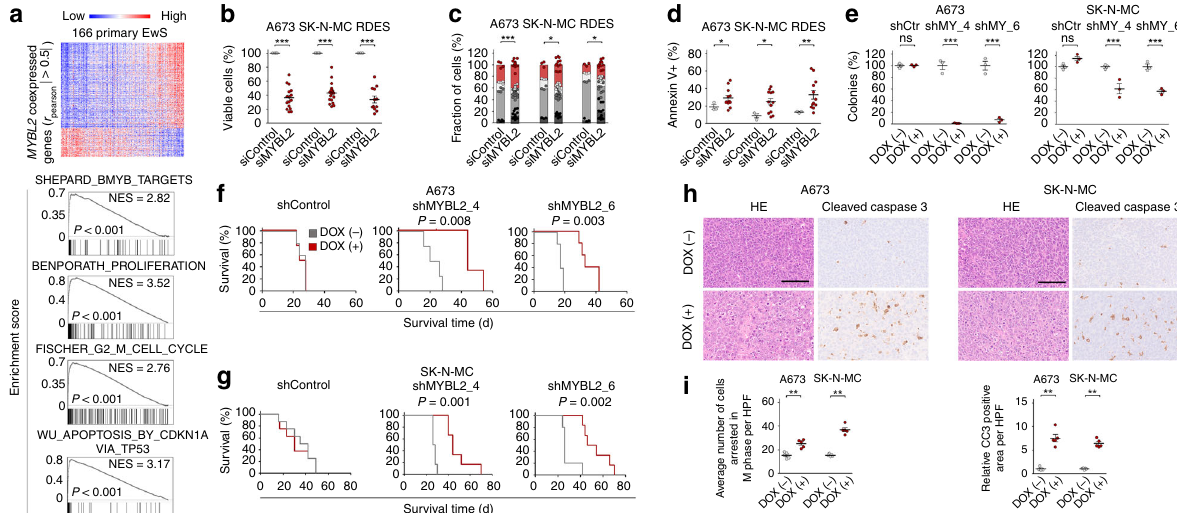
Fig. 2 MYBL2 is critical for proliferation and cell survival of EwS cells in vitro and in vivo. a Upper: Heat-map of genes whose expression is positively or negatively correlated with MYBL2 in 166 primary EwS. Lower: GSEA of the same dataset showing selected gene-sets enriched in MYBL2 high-expressing tumors. b Viable cell count 96 h after transfection of three EwS cell lines with either four different speci fi c siRNAs against MYBL2 (summary of four different siRNAs shown) or a non-targeting siControl. Horizontal bars represent means, and whiskers represent the SEM, n ≥ 3 biologically independent experiments. c Analysis of cell cycle and cell death (sub G1/G0) 96 h after transfection of three EwS cell lines as described in b , using PI staining. Dots show the percentages of cells per experiment delineating cell cycle phases, bars show the fraction of cells (%) in each cell cycle phase, n ≥ 3 biologically independent experiments. d Analysis of apoptosis 96 h after transfection of three EwS cell lines as described in b , using Annexin V/PI staining. Horizontal bars represent means, and whiskers represent the SEM, n = 3 biologically independent experiments. e Relative colony number of A673 and SK-N-MC cells containing either DOX-inducible speci fi c shRNA constructs directed against MYBL2 (shMY_4 refers to shMYBL2_4 and shMY_6 refers to shMYBL2_6) or a non-targeting shControl (shCtr). Cells were grown either with or without DOX. Horizontal bars represent means, and whiskers the SEM, n = 3 biologically independent experiments. f , g Kaplan – Meier survival analysis of NSG mice xenografted with A673 or SK-N-MC cells with/without DOX- inducible MYBL2 suppression. Once tumors were palpable, mice were randomized and treated with either vehicle ( – ) or DOX ( + ), n ≥ 4 animals per condition. P values determined via Mantel – Haenszel test. h Representative micrographs of xenografts stained with hematoxylin and eosin (HE) or for cleaved caspase 3 (CC3) by IHC. Scale bar is 100 µ m. i Quanti fi cation of cells arrested in M-phase and automated quanti fi cation of the picture area positive for CC3 (relative to control) of micrographs described in h . Horizontal bars represent means, and whiskers represent the SEM, n = 5 samples per condition. *** P < 0.001, ** P < 0.01, * P < 0.05; P values determined via two-tailed Mann – Whitney test. Source data are provided as a Source Data fi le